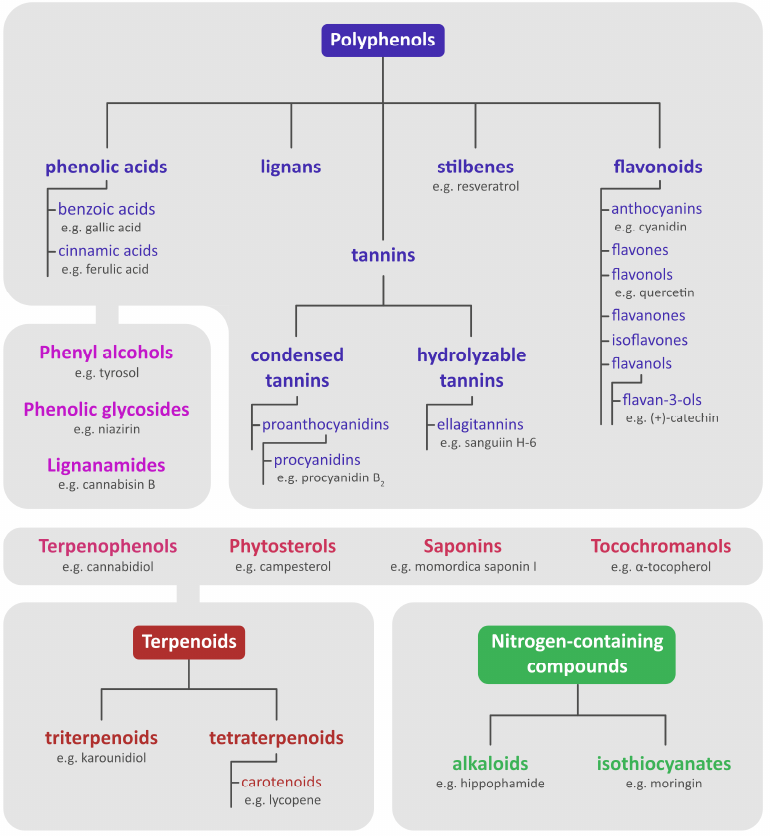
Figure 1. Classification of phytochemicals. The figure includes only the compounds that were mentioned in the text. Cojoined grey fields indicate a certain degree of structural similarity, or involvement of one group of phytochemicals or their precursors in the synthesis of the other. Compilation of data: [4,23,28–41].